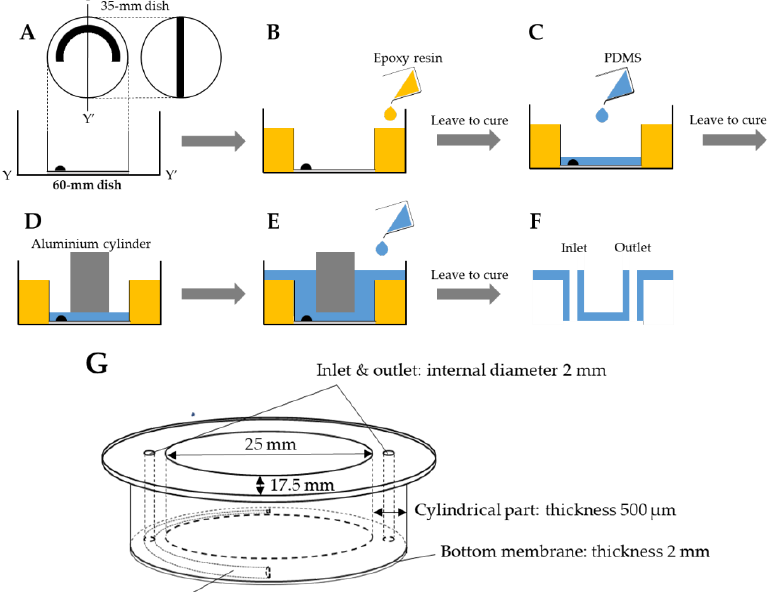
Figure 2. Manufacturing method of the culture dish adapter (CD-adapter). ( A ) Cut out a circular arc of 2.0 mm of width and 32 mm of outer diameter from a polyethylene sheet with a thickness of 500 µ m and paste it on the bottom of a 35-mm culture dish from Nunc and 2.0 mm from the edge. Place the 35-mm culture dish to which the circular arc was attached in the center of a 60-mm culture dish using double-sided tape. ( B ) Pour epoxy resin into the 60-mm culture dish and leave at 25 ◦ C for approximately 9 h to cure. ( C ) Pour 2 mL of polydimethylsiloxane (PDMS) into the 35-mm culture dish and let it stand at 25 ◦ C for approximately 6 h to cure. ( D ) Place an aluminum cylinder with a diameter of 25 mm at the center of the 35-mm culture dish. ( E ) Pour more PDMS around the aluminum cylinder and leave at 25 ◦ C for approximately 9 h to cure. ( F ) Remove the aluminum cylinder and culture dish from the PDMS and use a long-type biopsy punch with a diameter of 2 mm to make holes for injection and discharge. ( G ) CD-adapter made of PDMS compatible with a 35-mm culture dish. The adapter has an inlet and an outlet and a concave groove at the bottom for equalizing the flow in the culture dish. The depth of the groove is 500 µ m, the diameter of the inlet and outlet is 2.0 mm, and the membrane thickness of the bottom surface of the adapter is 2.0